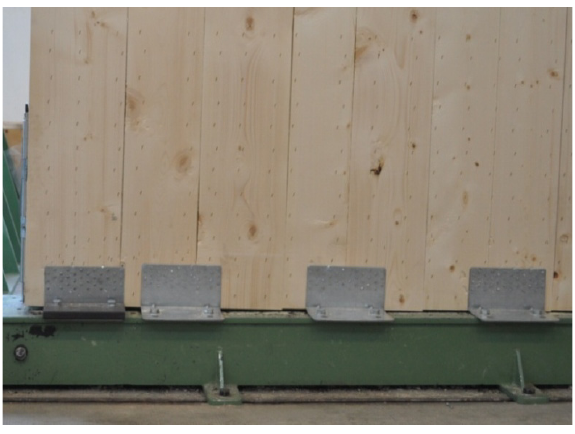
Figure 12. Wall B: Detail of angle uplift at end of testing.